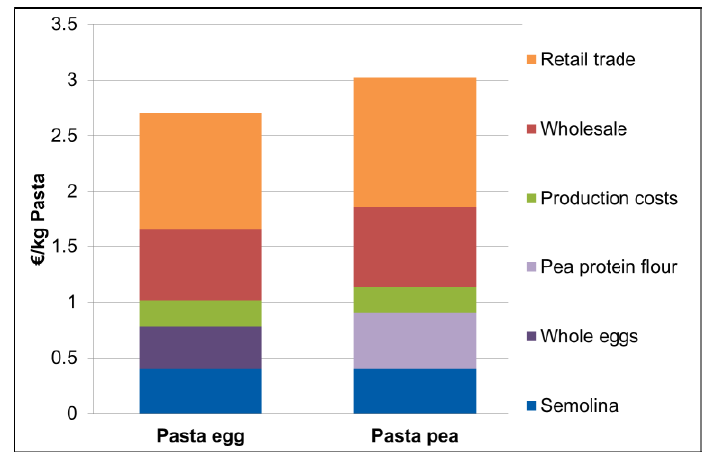
Figure 2. Price calculation for Pasta egg and Pasta pea .